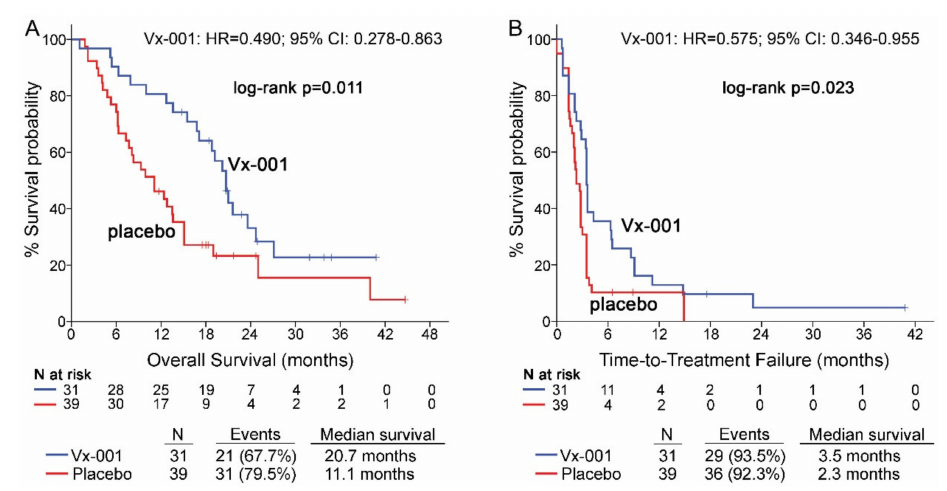
Figure 4. OS and TTF in patients with GZMB-TIL low tumors. OS ( A ) and TTF ( B ) were measured in patients with GZMB-TIL low